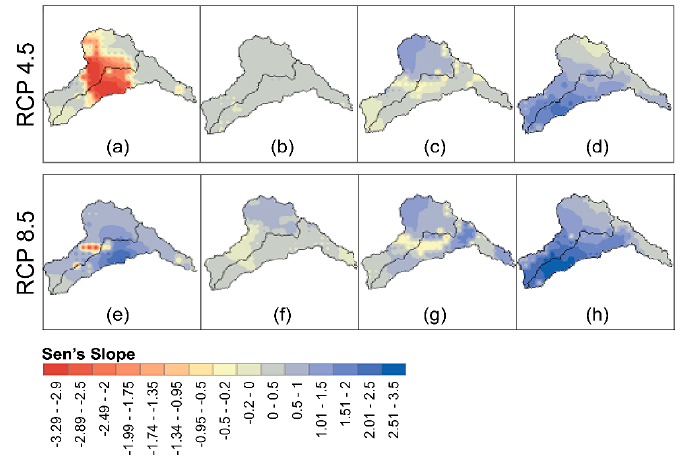
Figure 12. The seasonal precipitation trends in the study area for ( a ) warm-wet RCP 4.5, ( b ) cold-dry RCP 4.5, ( c ) cold-wet RCP 4.5, ( d ) warm-dry RCP 4.5, ( e ) warm-wet RCP 8.5, ( f ) cold-dry RCP 8.5, ( g ) cold-wet RCP 8.5 and ( h ) warm-dry RCP 8.5.